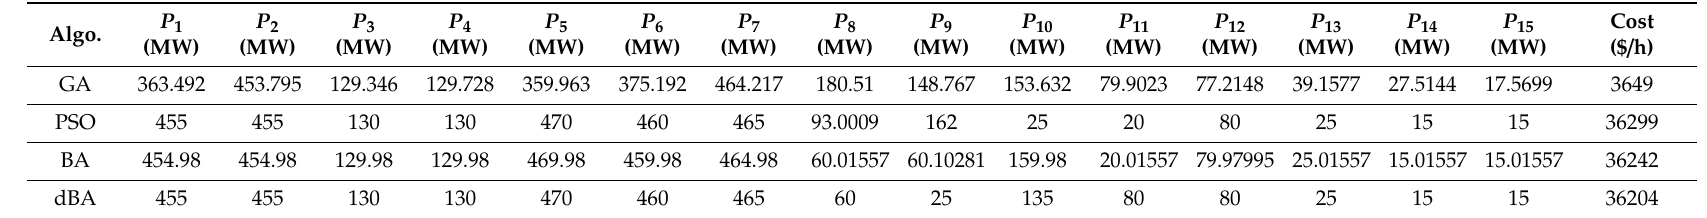
Table 13. Cost comparison for 3000 MW demand without renewables.